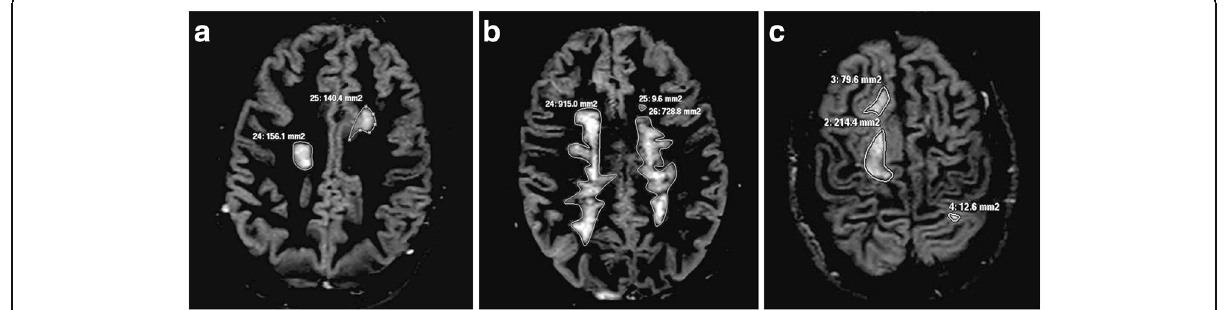
Fig. 3 Axial DIR images showing contouring and segmentation method of MS plaques for calculation of total lesion load